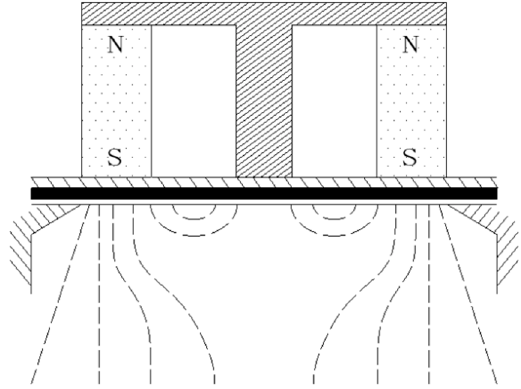
Figure 2. Schematic diagram of unbalanced magnetron sputtering principle.